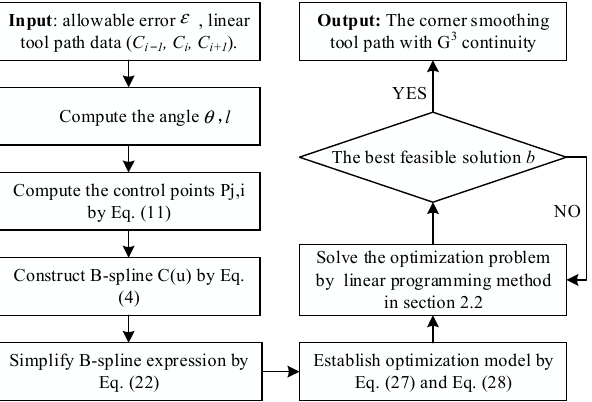
Figure 2. Flowchart of the proposed method.